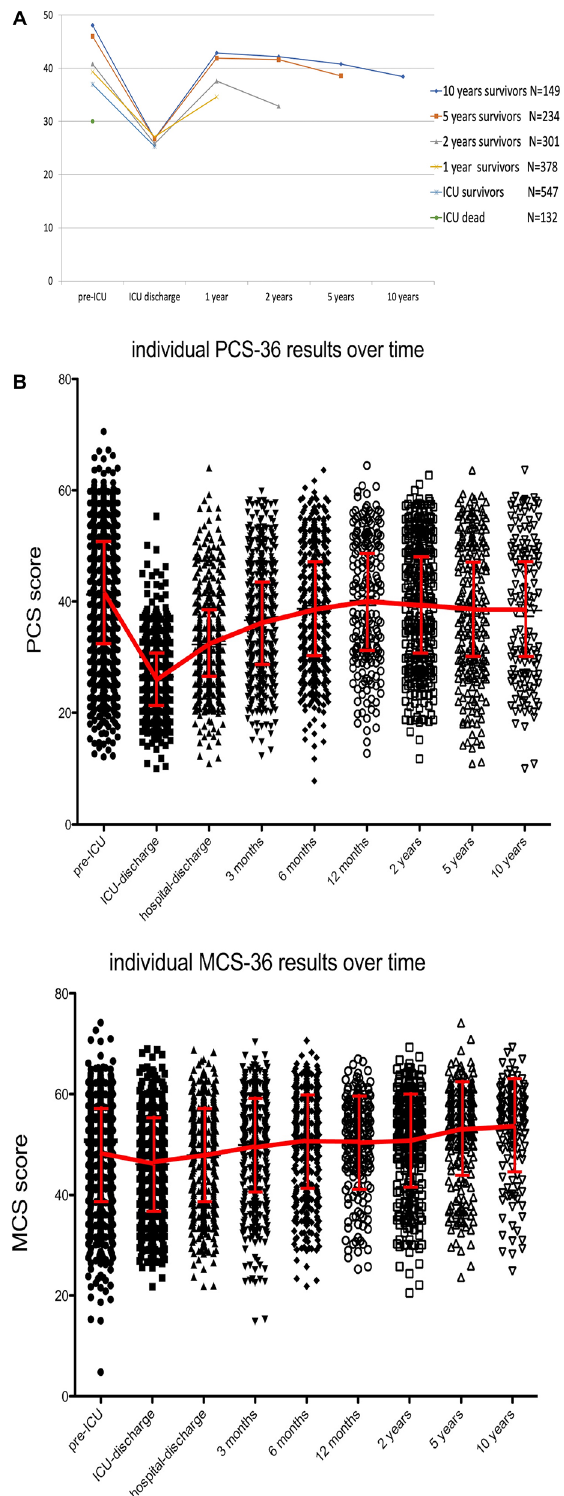
Figure 2. Panel ( A ) Course of mean physical component score over time. with different survival time (raw uncorrected data). Panel ( B ) Individual physical component score Short form F-36 and mental component score Short Form-36 results over time; Red lines indicate mean